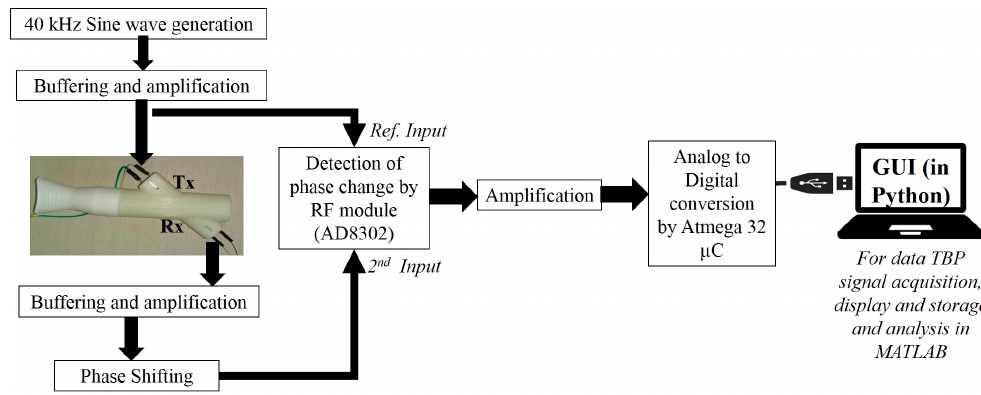
Figure 1. The entire system architecture comprising the flow pipe, the electronic circuitry and acquisition in laptop through Python-based bespoke software GUI. TBP: tidal breathing pattern